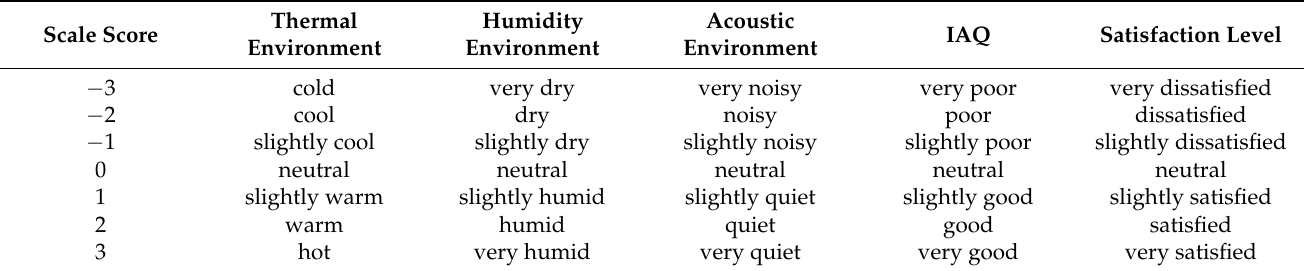
Table 3. Options of subjective evaluation scale for IEQ